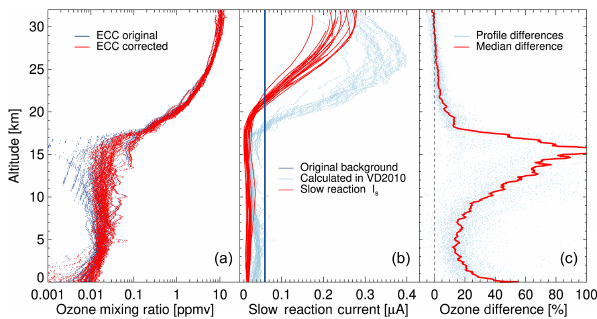
Figure 13. (a) Original and reprocessed CEPEX ozonesonde pro- files. (b) Original constant background, reprocessed background following VD2010, and slow-reaction contribution. (c)